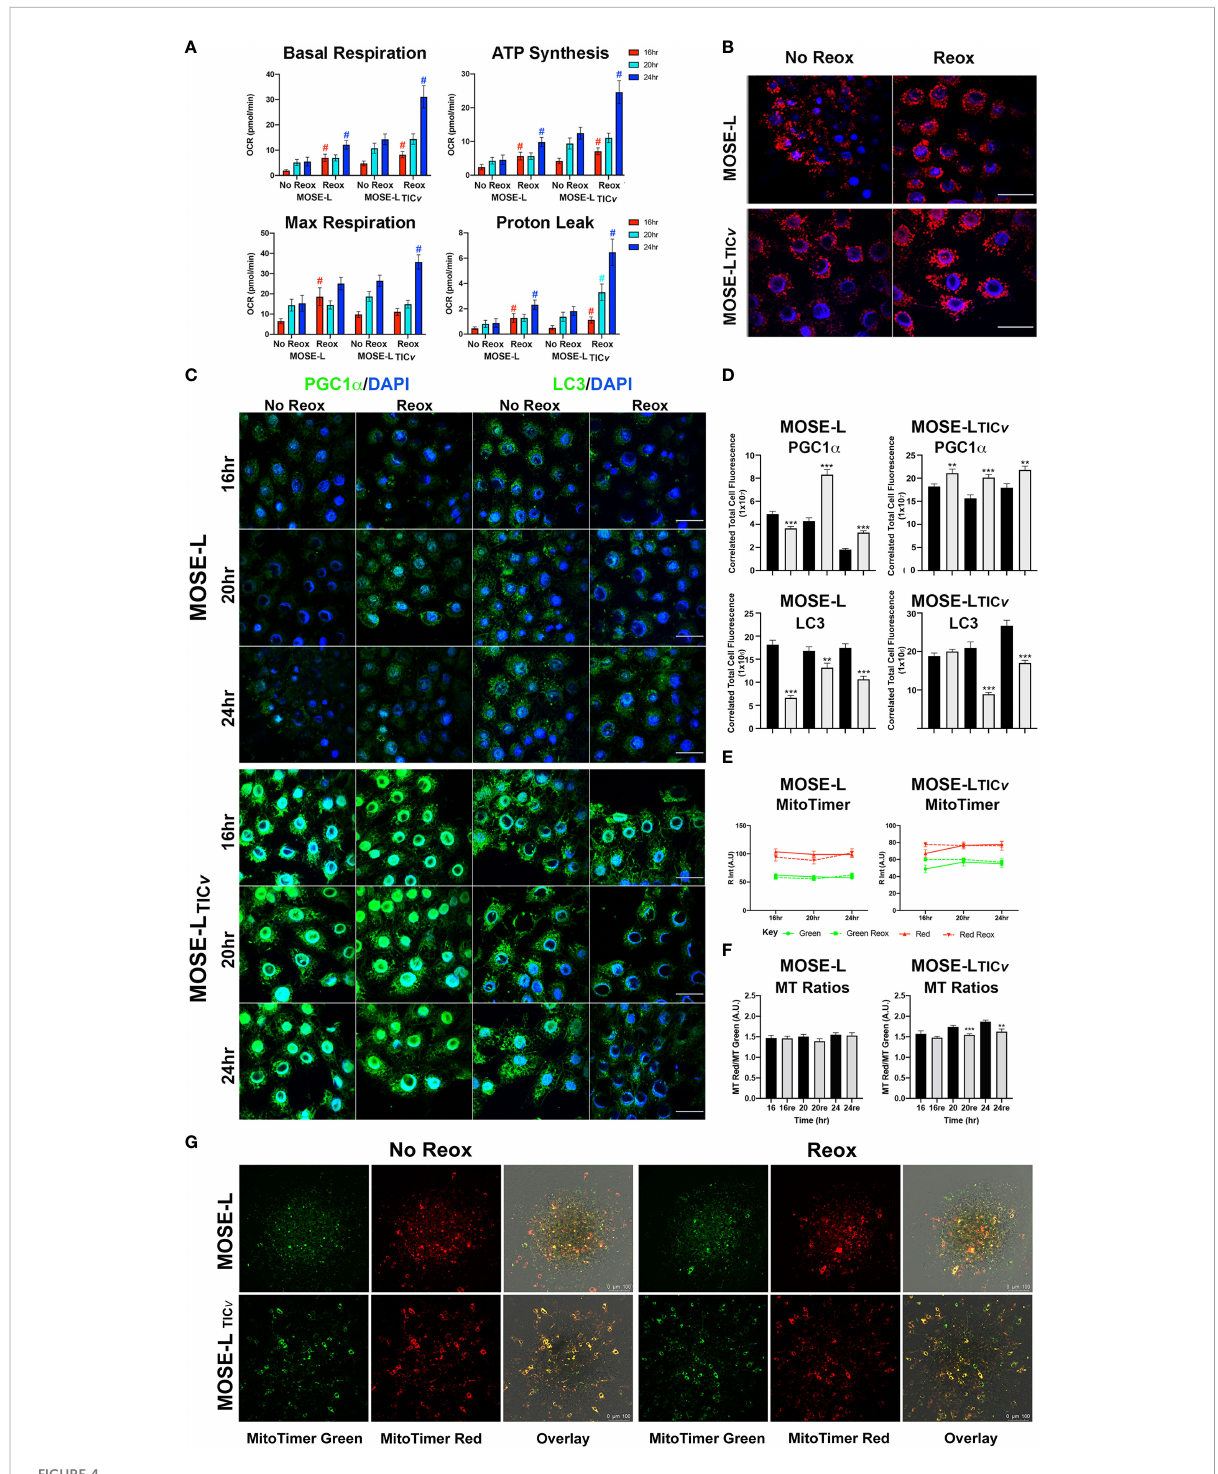
FIGURE 4 Adhesion-induced mitochondrial plasticity allows for adaptations to changed culture conditions. (A) Seahorse XFe96 analyses of cellular respiration; #p<0.05 reox group compared to non-reox counterpart for each timepoint and cell type. (B) Outgrowth imaging of cells stained with MitoTracker CMXRos and DAPI after 24 h adherence of spheroids in non-reox vs . reox conditions. (C, D) Outgrowth imaging and quantitation of 16-24 h spheroids immunostained with PGC1 a /DAPI and LC3/DAPI. (E) MATLAB quanti fi cation of MitoTimer fl uorescence intensity in reox vs . non reox conditions; green indicates mitobiogenesis, red indicates hydrogenated MitoTimer over time. (F) MitoTimer red: green fl uorescence intensity ratios. **p<0.01 ***p<0.001vs. the non-reox counterparts. Scale bar set at 50µm. (G) MitoTimer expression in the outgrowth of adherent